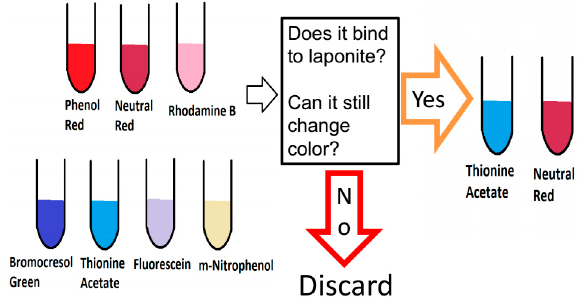
Figure 1. Summary of the procedure for the dye selection. We selected only the dyes showing irreversible binding to Laponite ® , and change of color upon pH change (visually, by UV-Vis absorption and fluorescence emission).